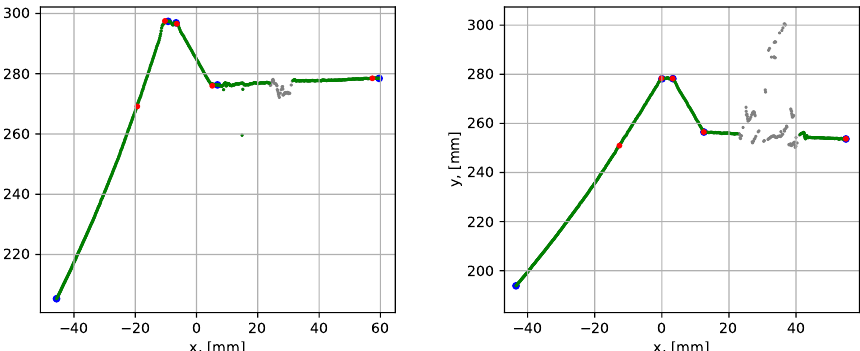
Figure 22. Parametrization results with groove corner points for datasets 6 (to the left) and 7 (to the right). The blue dots show the result before the iterative error elimination procedure and the red dots show after. The grey points have been identified as noise by the noise detection algorithm.